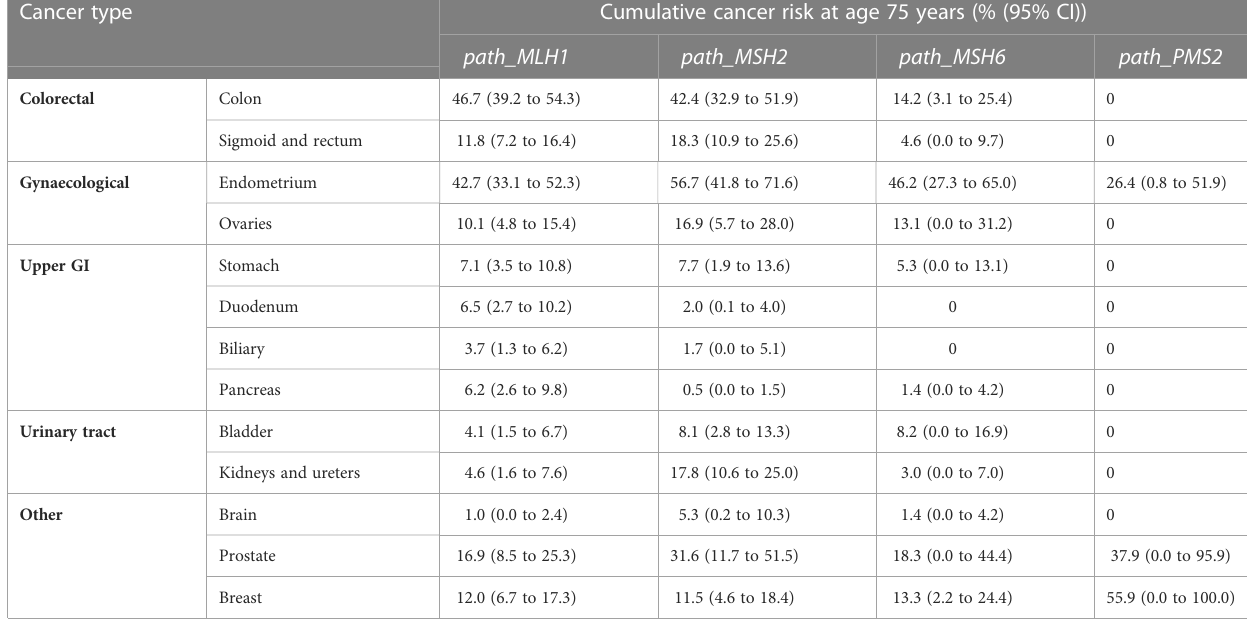
TABLE 1 Cumulative incidence of individual cancers in patients with pathogenic MMR variants between 25-75 years old (23). Cancer